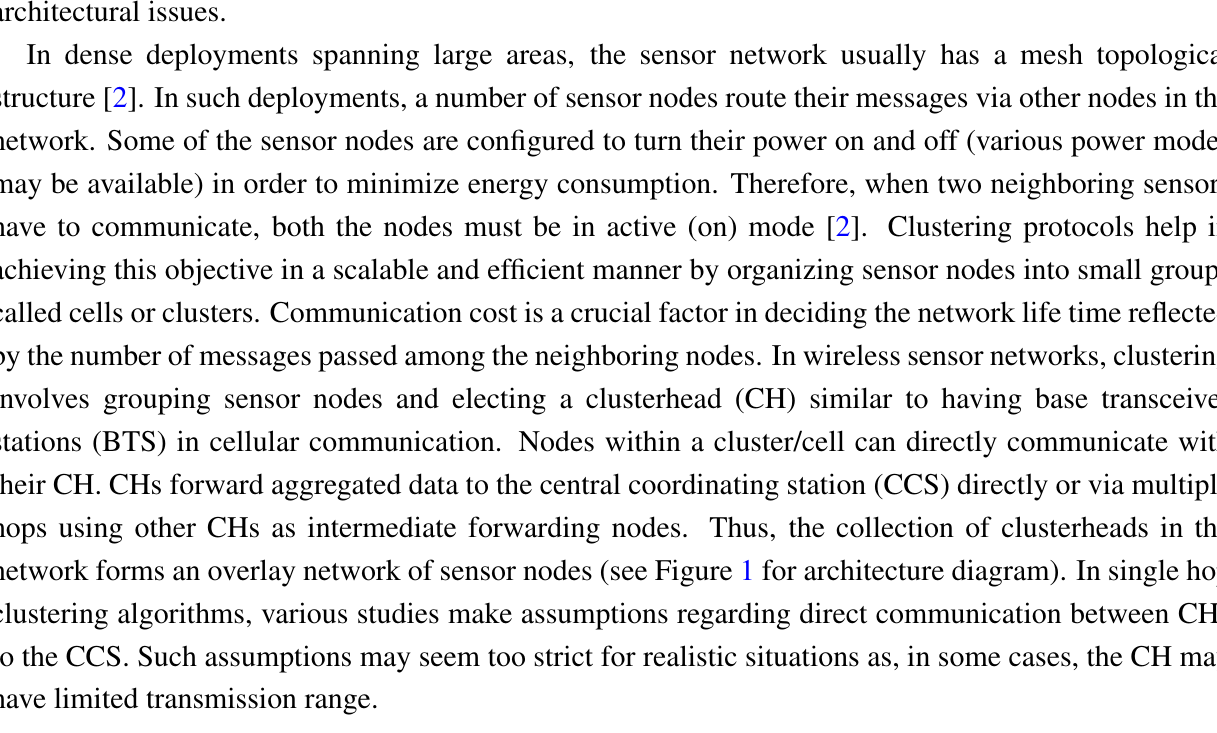
Figure 1. Hierarchical cooperative communication